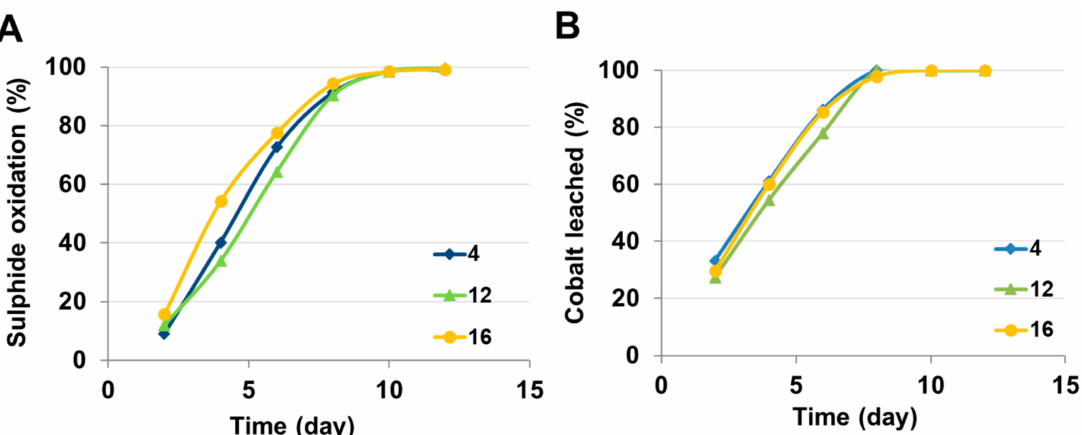
Figure 5. Calculated percentage of ( A ) sulphide oxidation and ( B ) cobalt in leachate for iron amendment in nutrient medium (4 K, 12 K, and 16 K)